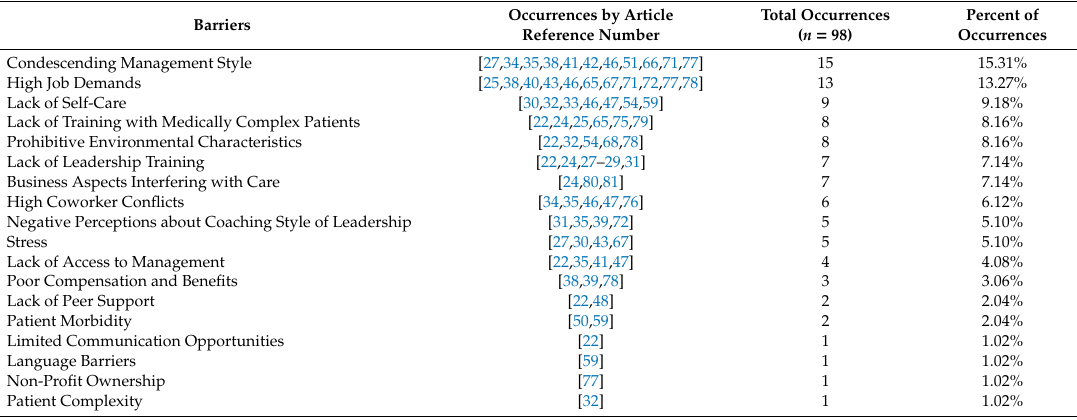
Table 2. Summary and frequency of barriers identified as impacting job